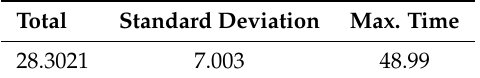
Table 6. Computing time in